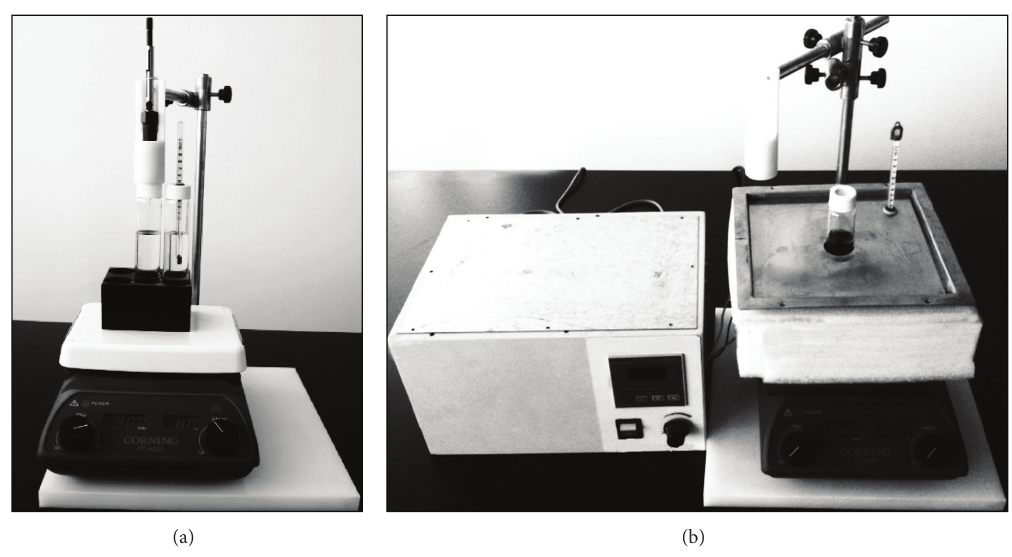
Figure 1: (a) The original magnetic stirrer from CORNING and (b) modified